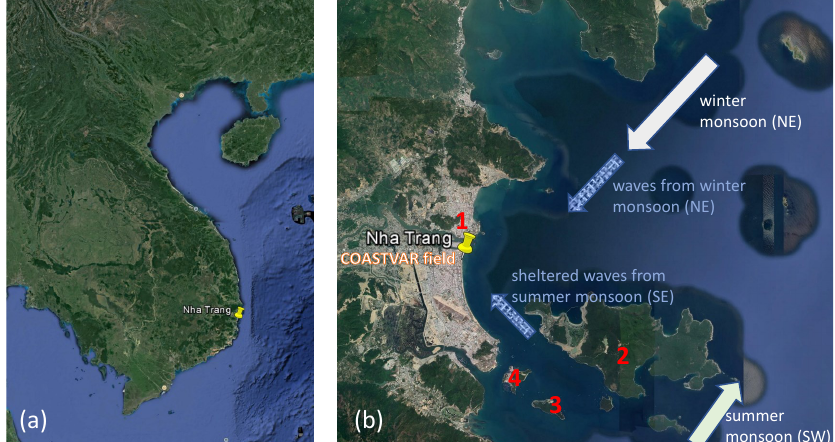
Figure 2. ( a ) Location of Nha Trang beach on Vietnam map. ( b ) Nha Trang bay with Cai River estuary (1) in the north and a group of islands in the south, e.g., Hon Tre (2), Hon Tam (3), and Hon Mieu (4).